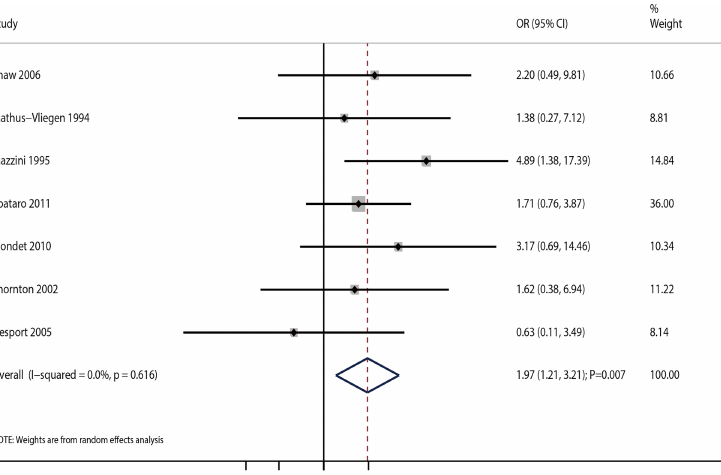
Fig 4. Association of PEG use and 20-month survival